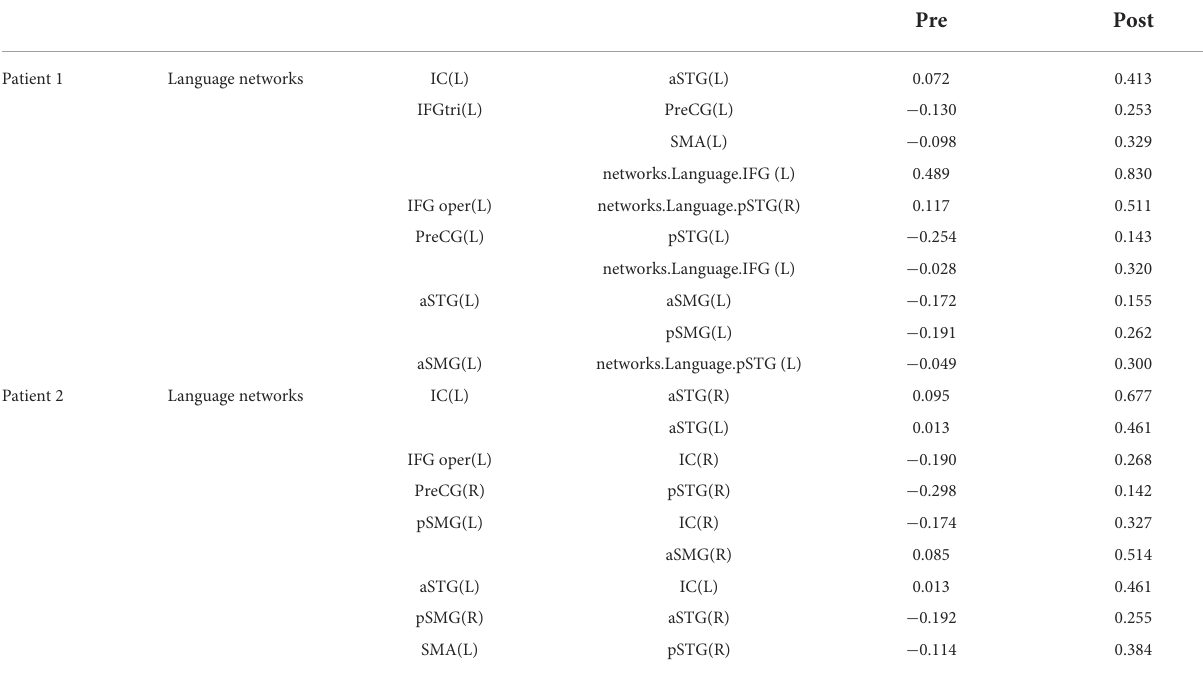
TABLE 2 Correlation coefficient results of region-of-interest (ROI) to ROI of language